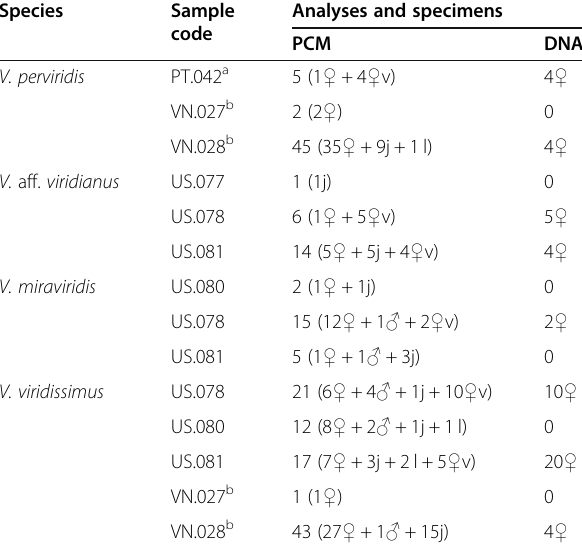
Table 1 List of species and populations used in analyses. Types of analyses: PCM – imaging and morphometry in PCM; DNA – DNA sequencing. The number in each analysis indicates how many specimens were utilized for a given method: ♀ – sexually mature females, ♂ – sexually mature males, j – juveniles, l – larvae, v – vouchers (please note that in some cases, the same specimens were used for both DNA and LCM